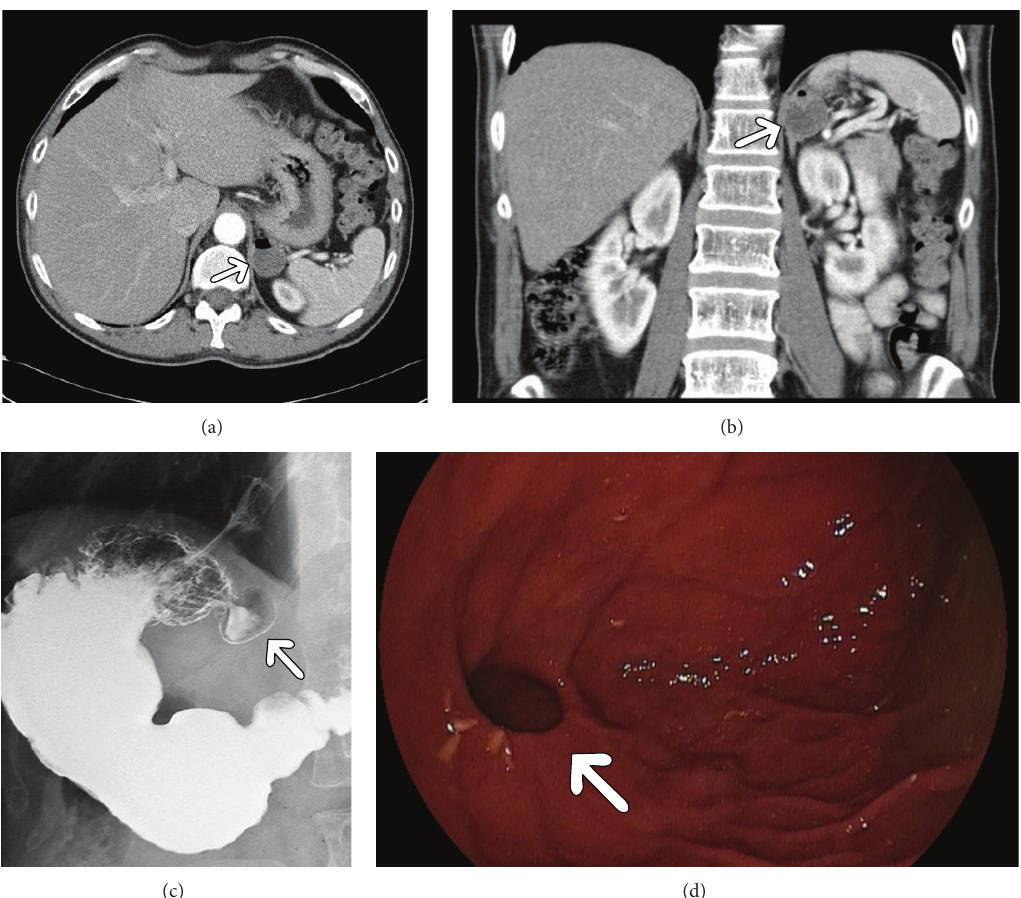
Figure 1: Imaging findings in a 57-year-old patient. (a) Computer tomographic scan detecting a mass in the left paravertebral region behind the stomach with air fluid level (arrow). (b) The lesion (arrow) in coronal CT reconstruction. (c) Upper gastrointestinal investigation with contrast showing a gastric diverticulum in the cardia on the posterior gastric wall below the esophagogastral junction (arrow). (d) Endoscopy finding with entry of the diverticulum